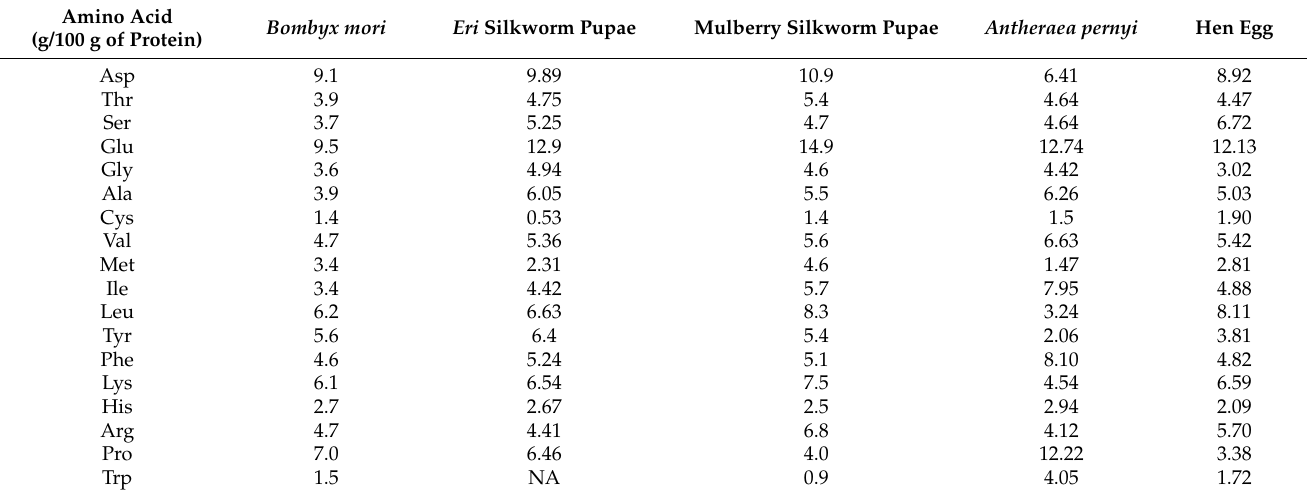
Table 1. Amino acid composition of different varieties of silkworm pupae proteins [9,21,22,24]. Amino Acid (g/100 g of